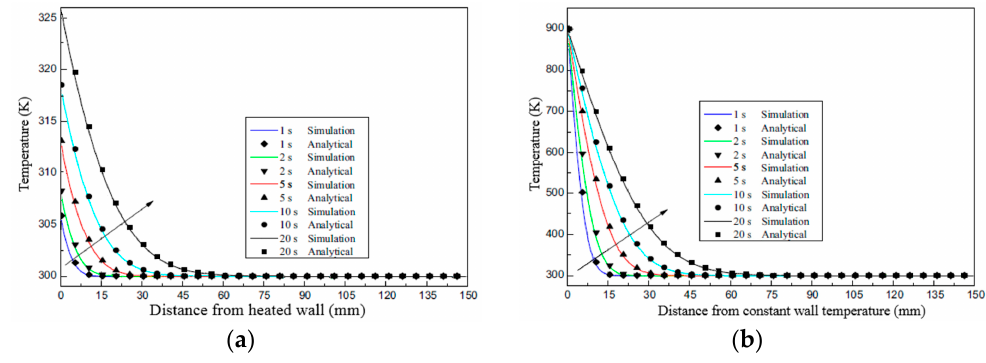
Figure 12. Temperature profiles case ( a ) T w = 900 K and case ( b ) heat flux q w = 70 kw